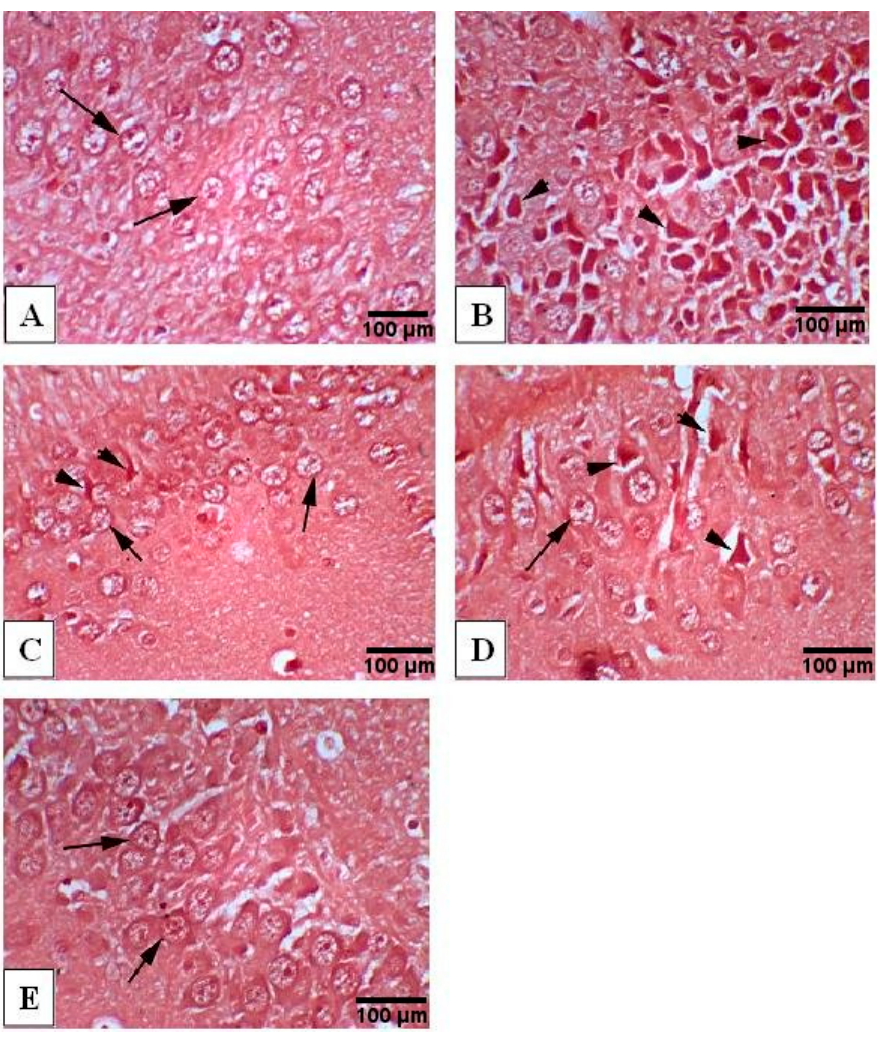
Figure 7. Photomicrographs of Congo red-stained hippocampus tissue (400x). ( A ) Normal group exhibiting normal histology structure of hippocampus with normal neuronal cells (arrow), ( B ) AlCl 3 -treated group exhibiting marked multifocal A β deposition in hippocampus (arrow head), ( C ) AlCl 3 /rivastigmine-treated group showing normal appearance of hippocampus with intact neuronal cells (arrow) combined with mild multifocal A β deposition (arrow head), ( D ) AlCl 3 /low dose of the extract-treated group showing normal histological appearance of hippocampus with intact neuronal cells (arrow) as well as mild to moderate multifocal A β deposition (arrow head), ( E ) AlCl 3 /high dose of the extract-treated group showing normal histological appearance of hippocampus with intact neuronal cells (arrow).